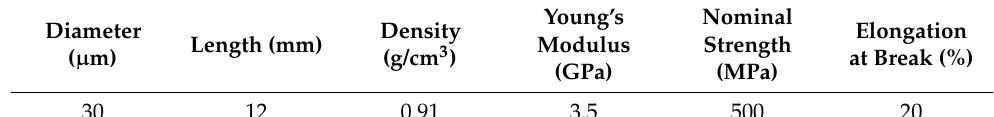
Table 2. Physical properties of PP fiber.